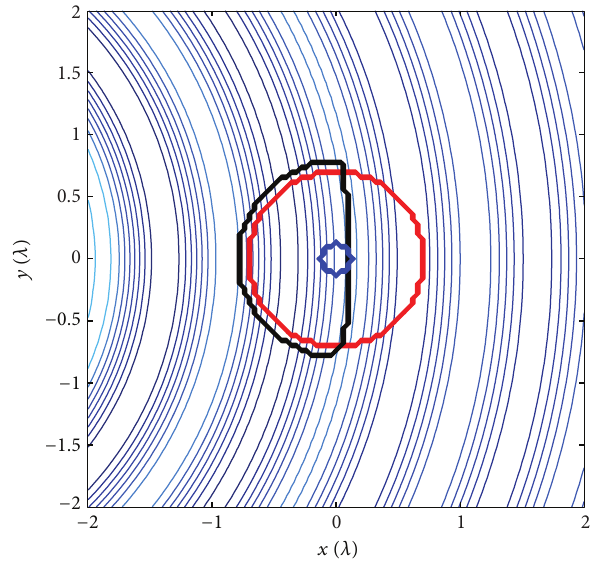
Figure 12: Improved boundary of the minimum source region, whichessentiallycoincideswiththetruetargetsupport,correspond- ing to three test origins: (𝑥 = 2, 𝑦 = 2) , (𝑥 = 0, 𝑦 = 10) , and (𝑥 = 0, 𝑦 = 0) . Also shown is the contour plot of the amplitude of the backpropagated field associated to the field data.